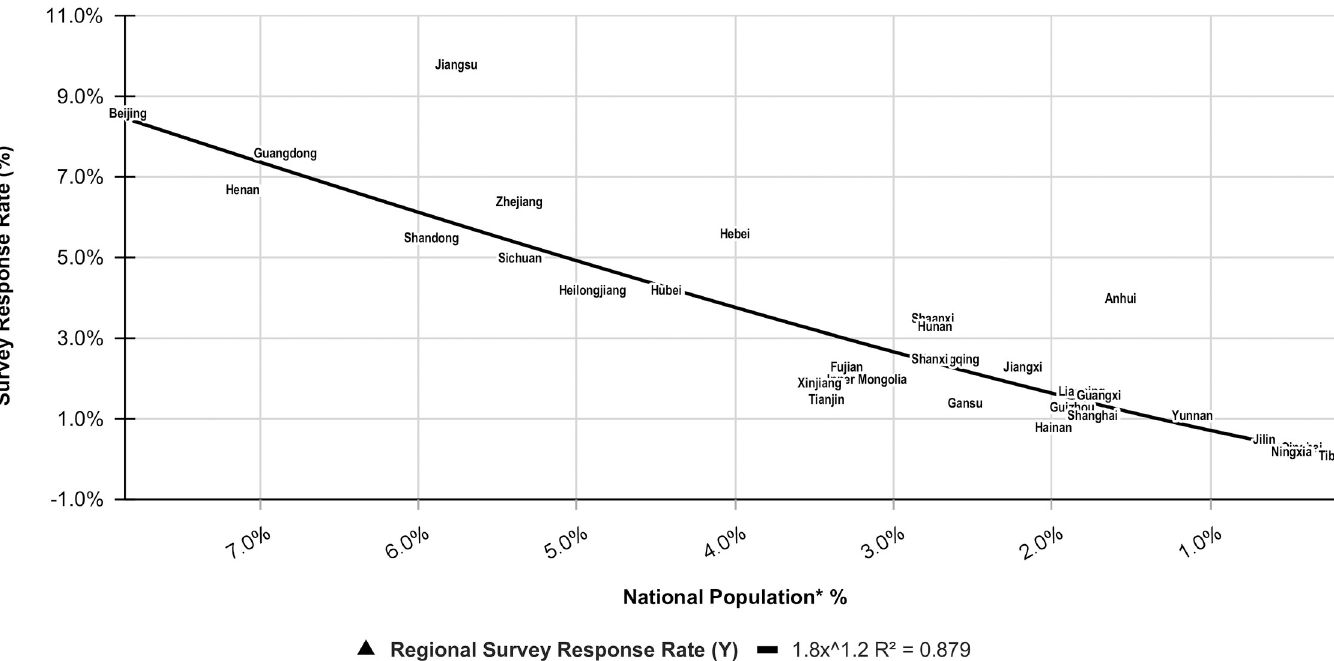
Fig 1. Correlation between the national population percentages and the survey response rates in 31 regions in mainland China. � Based on the data from National Bureau of Statistics of China. Annual by Province. 2015. Accessed December 13, 2020. available from: https://data.stats.gov.cn/english/easyquery.htm?cn=E0103.